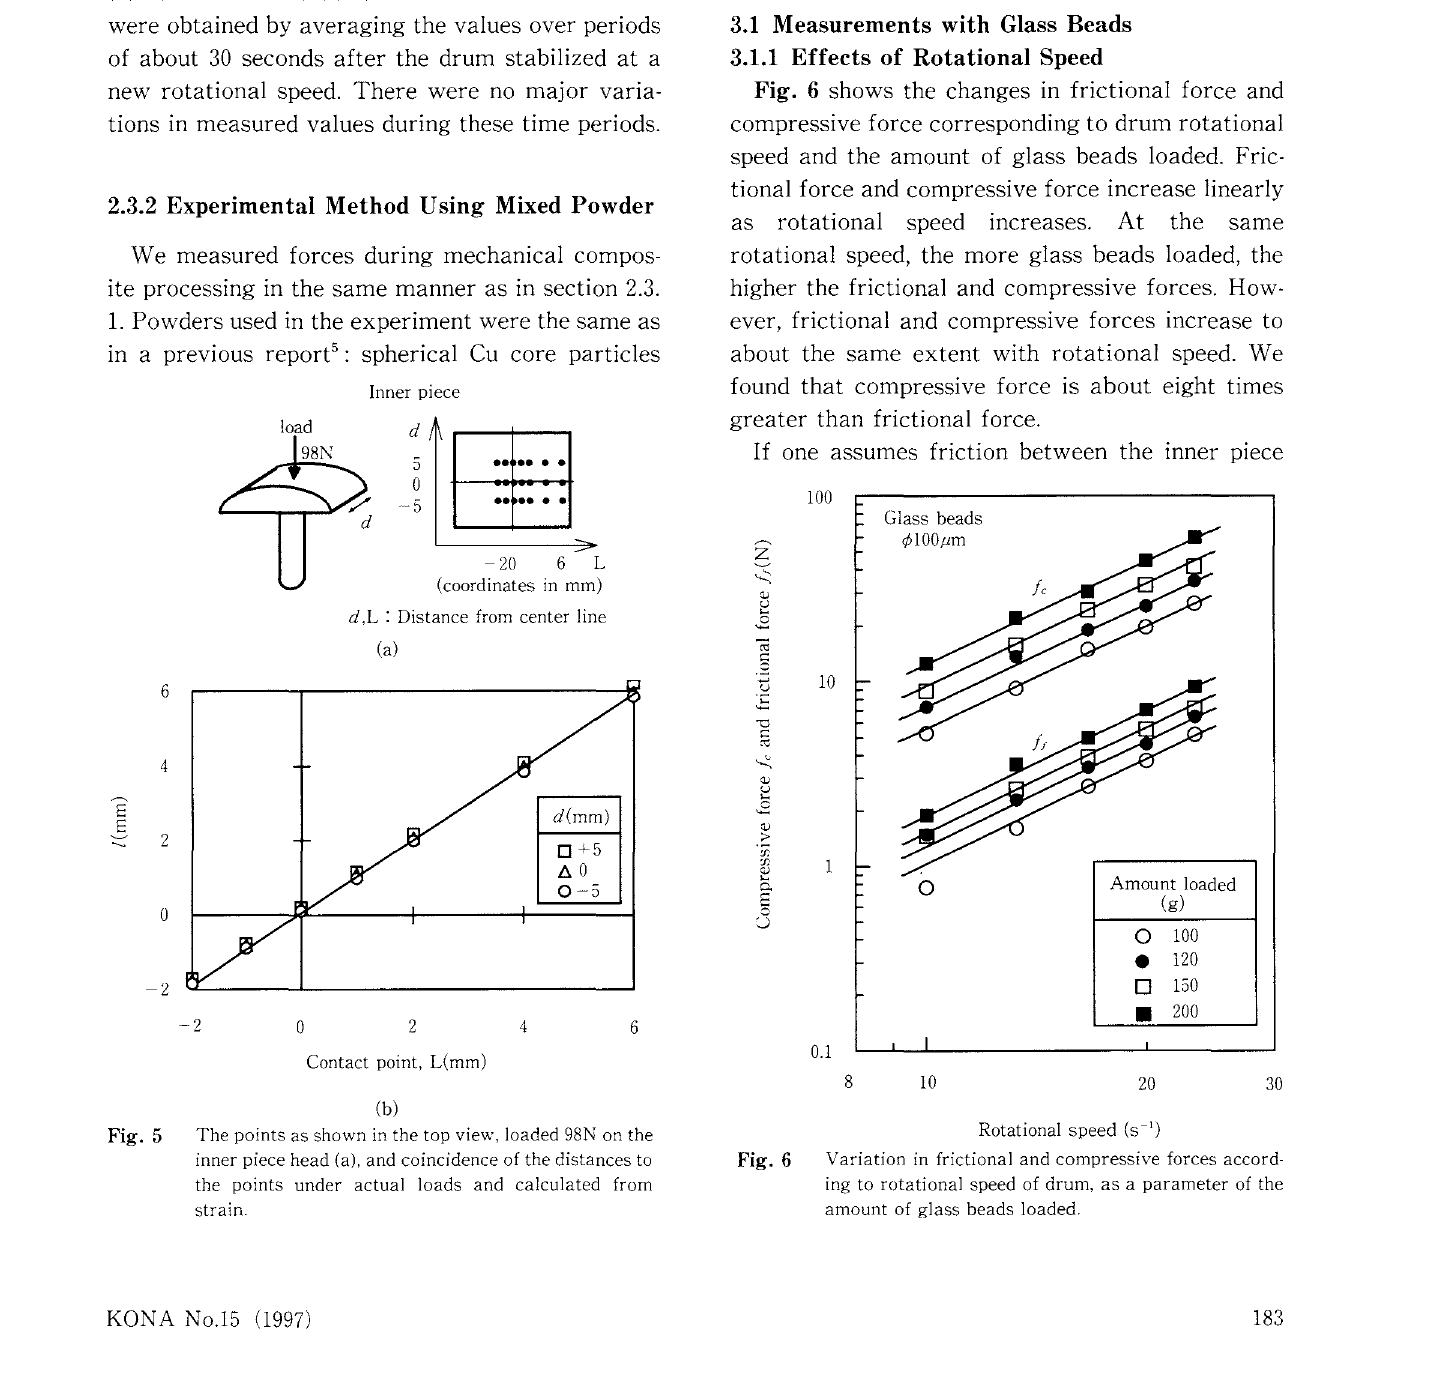
The points as shown in the top view, loaded 98N on the inner piece head (a), and coincidence of the distances to the points under actual loads and calculated from strain.